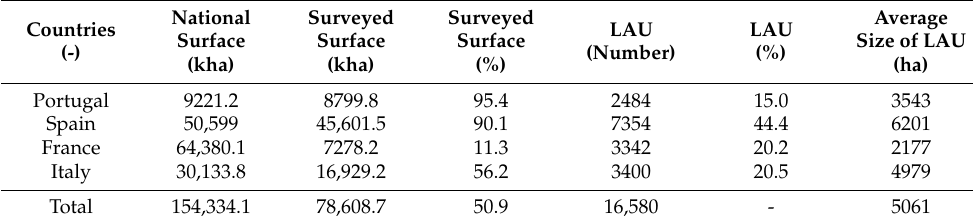
Table 1. National surface, surveyed surface (in kha and %), land administrative units (LAUs) (in number and %), and the average size of LAU for each